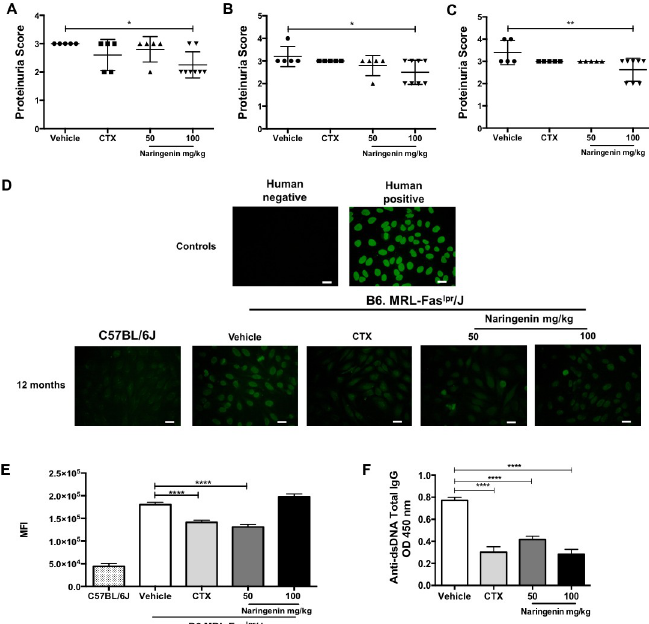
Fig 2. Naringenin alleviates the main signs of SLE in B6.MRL-Fas lpr /J mice. Proteinuria was semi-quantitative evaluated by test strips every month. (A-C) The mice provided with the highest dose of Naringenin treatment showed a reduction in the proteinuria score from the first to third month. (D) ANA IgG was determinate using 1:50 from each serum sample. Staining was performed with goat anti-mouse IgG FITC and observed in Eclipse epifluorescence microscope. The negative and positive controls were provided by the manufacture (conjugate anti-human IgG, FITC- labelled). Bars, 25 μ m. Naringenin treatment at 50 mg/kg diminished the presence of ANAs. (E) Mean fluorescence intensity of ANAs IgG. Analysis was performed using ImageJ software. (F) Serum concentration of anti-dsDNA was measured by ELISA assay. Naringenin treatments reduced significantly the titers of anti-dsDNA. Statistics was determinate by one-way ANOVA followed by Dunnett (A-B) and Tukey’s test (E-F). Data presented as mean ± SD, n � 5 mice. � p � 0.05, �� p � 0.01, ��� p � 0.001, ���� p � 0.0001 versus vehicle.